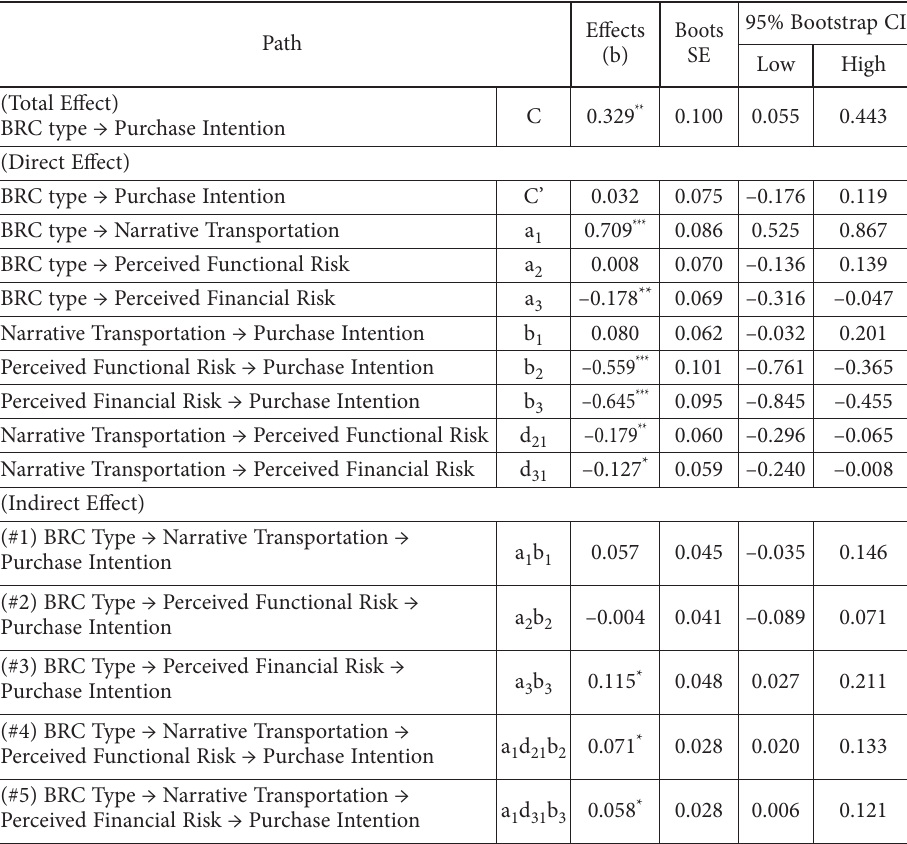
Table 2. Results summary of serial-parallel mediation model